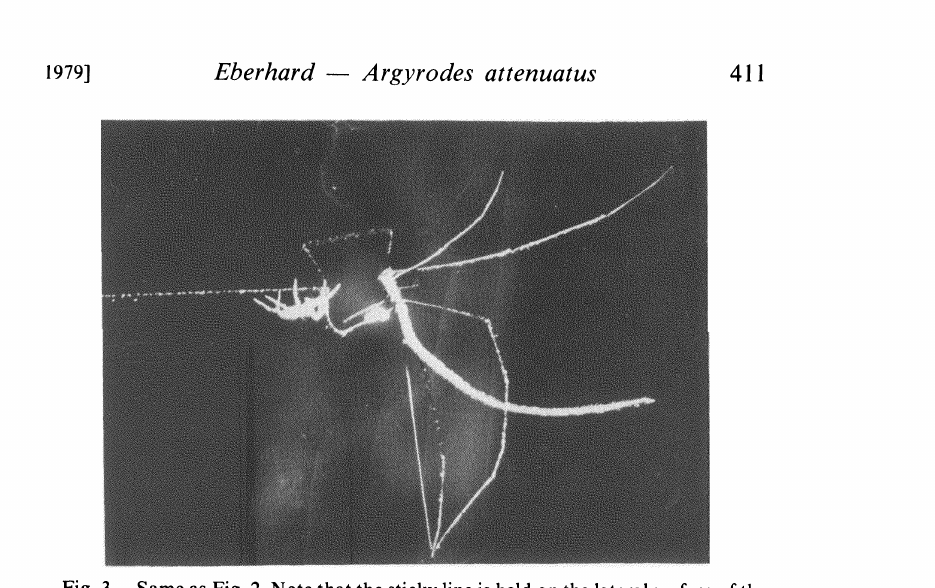
Fig. 3. Same as Fig. 2. Note that the sticky line is held on the lateral surface of the spider’s right leg IV. The line to the left of the A. attenuatus is coated with white powder, while that to the right is uncoated and thus